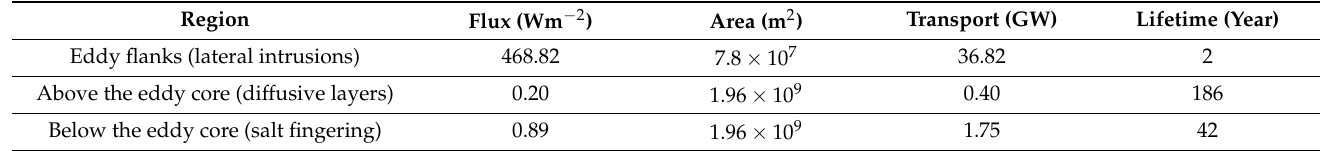
Table 3. Heat flux, transport and lifetimes for each edge of the meddy